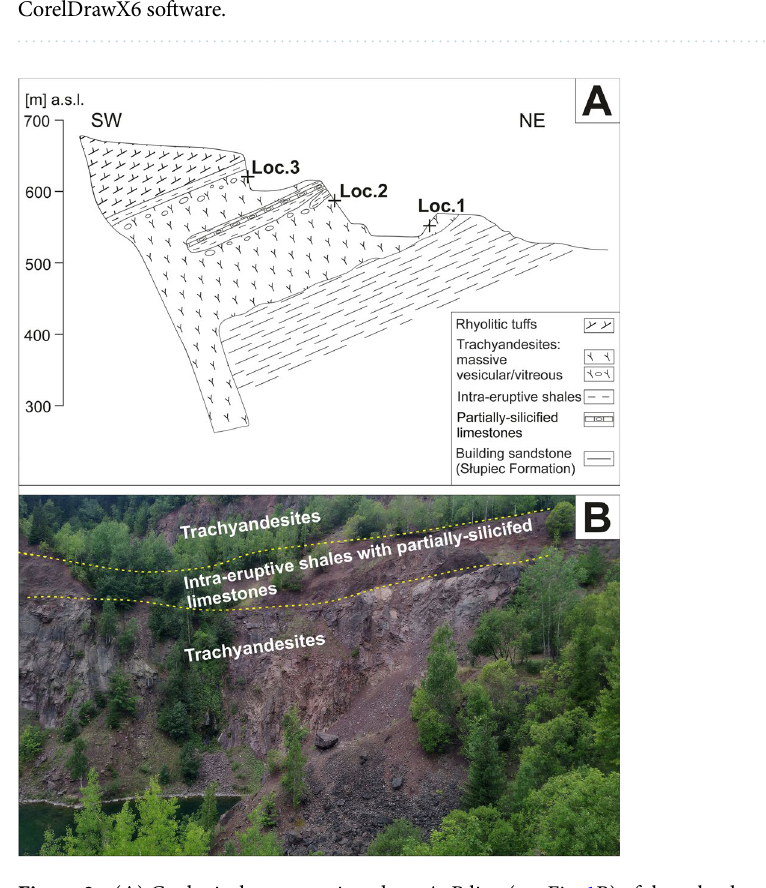
Figure 1. ( A ) Distribution of Carboniferous and Permian volcanic rocks within the Intra-Sudetic Basin (ISB)—modified after various sources, i.e. 24 . Note the inset map in the lower left show the position of the Basin within Poland area; ( B ) Geological sketch showing main lithologies found in the close vicinity of trachyandesite laccolith-type body exposed in the vicinity of Głuszyca village (after: 33 , modified). The map was generated using CorelDrawX6 software.